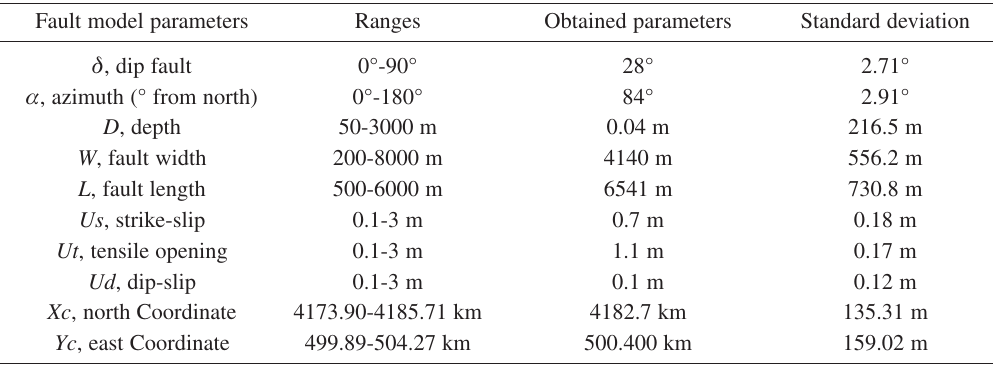
Table I. Search range for the fault model parameters. The coordinates are in UTM-WGS84 projection. Para- meters for the piezomagnetic fault source modelling the deformation and magnetic data recorded during the on- set of 2002 NE Etna flank eruption. The standard deviation of each parameter is computed over 50 different runs of GA.